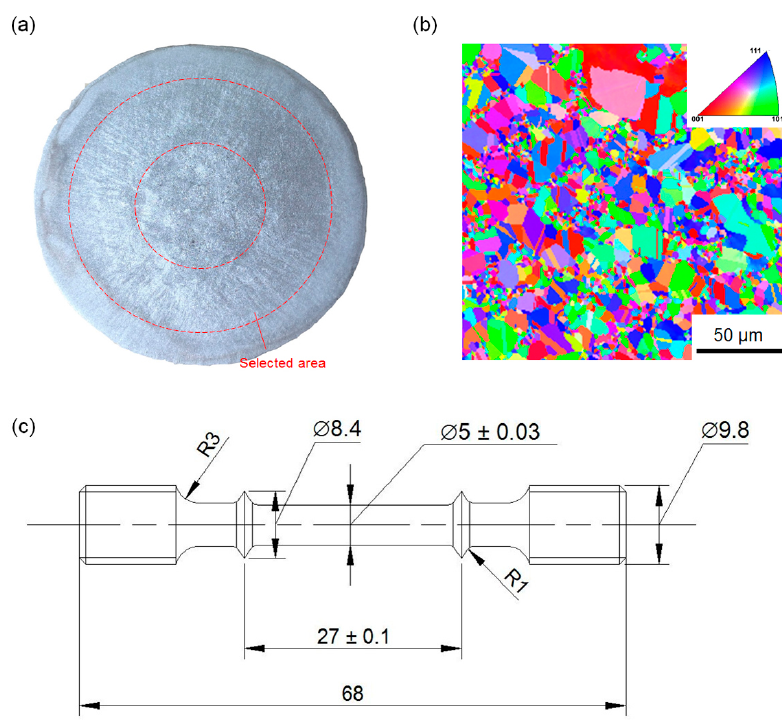
Figure 1. ( a ) Cross section of the extrusion ingot. The annular region between red dashed lines is the selected area to manufacture the specimens; ( b ) Microstructure of the as-extruded material; ( c ) Specimen drawing for creep test (unit: mm).